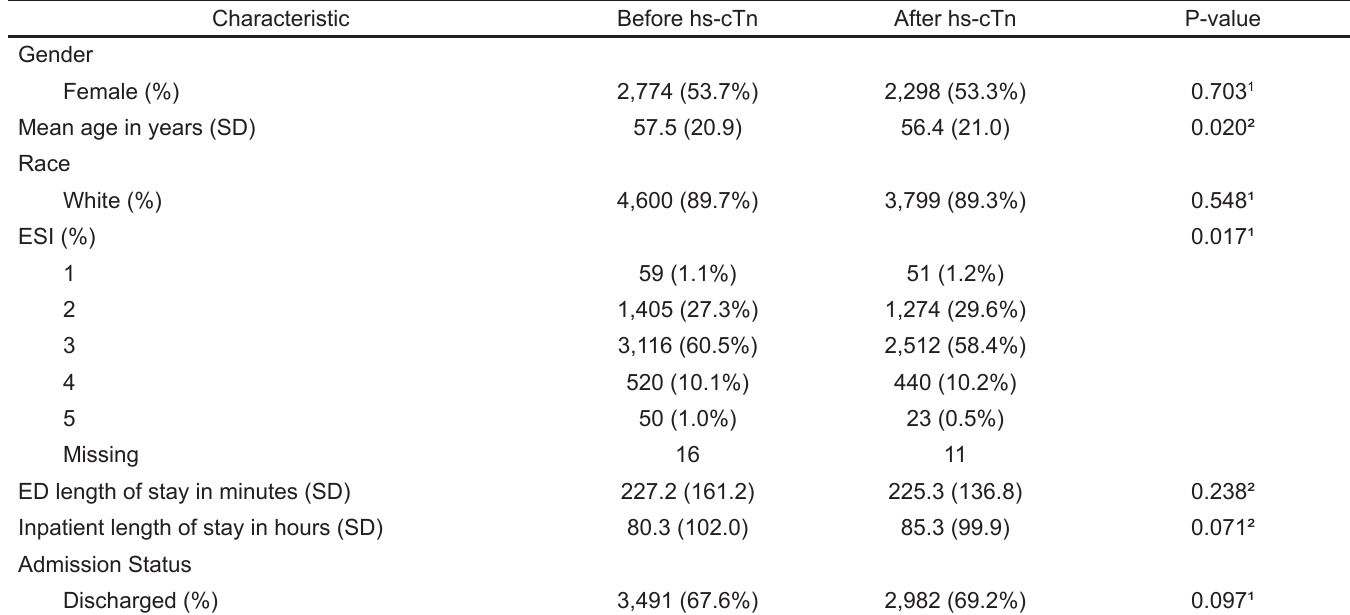
Table 1. Encounter characteristics before and after hs-cTn introduction.